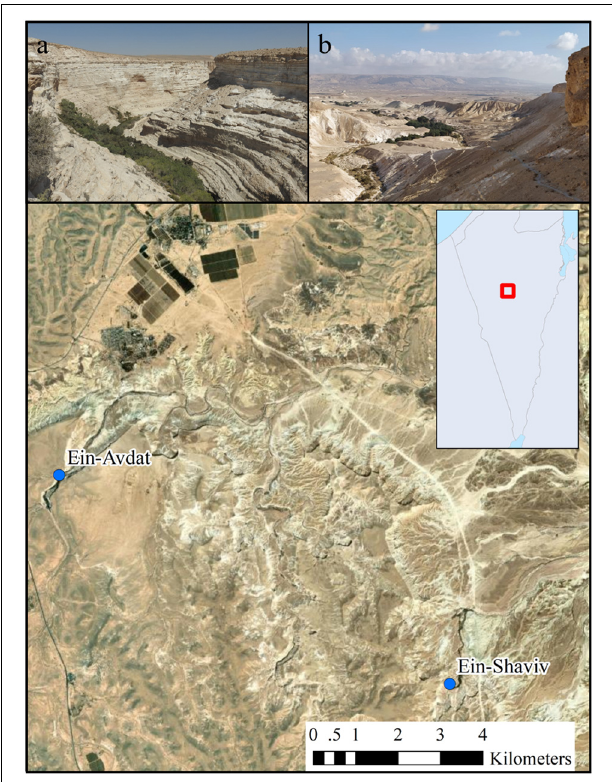
FIGURE 1 | A map of the study area that includes the two desert oases: (a) Ein-Avdat (photography by Yuval Zukerman) and (b) Ein-Shaviv (photography by Tomer